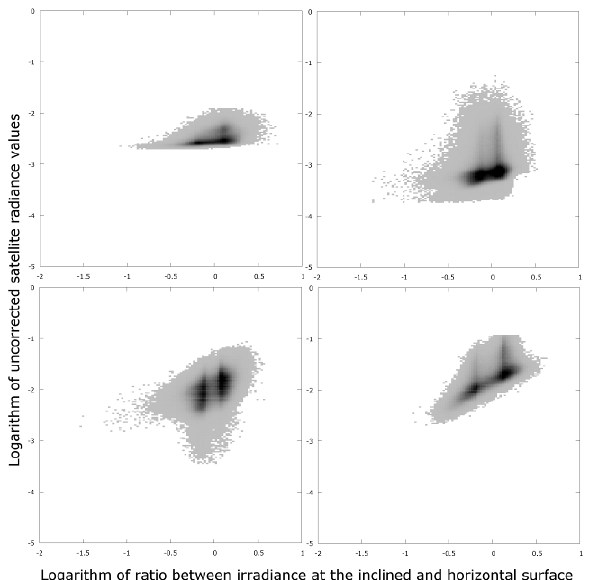
Figure 2. Density scatter plots of the reflectance values of different spectral bands that are used in the linear regression when determining optimal model and coefficient